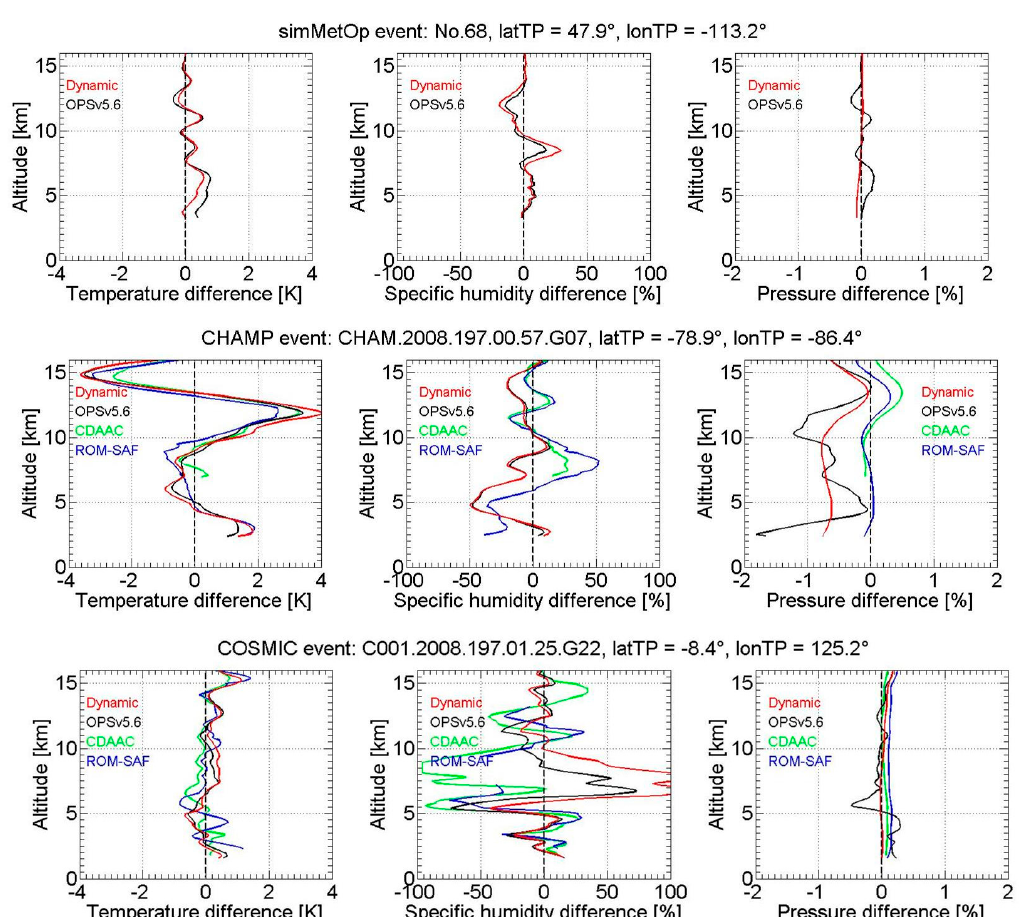
Figure 5. Difference profiles between RO-retrieved temperature (left column), specific humidity (middle column), and pressure profiles (right column) and their corresponding ECMWF co-located analysis profiles, for three exemplary events (identified on top of each row) from simMetOp (top row), CHAMP (middle row), and COSMIC (bottom row), respectively. The results for the dynamic (red), OPSv5.6 (black), CDAAC (green), and ROM-SAF (blue) approaches are shown.